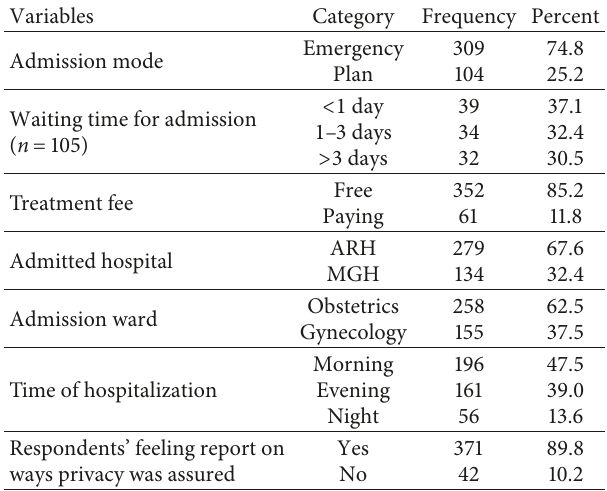
Table 1: Sociodemographic characteristics of the respondents admitted to obstetrics and gynecology wards of public hospitals in Mekelle town, Tigray Region, 2016.